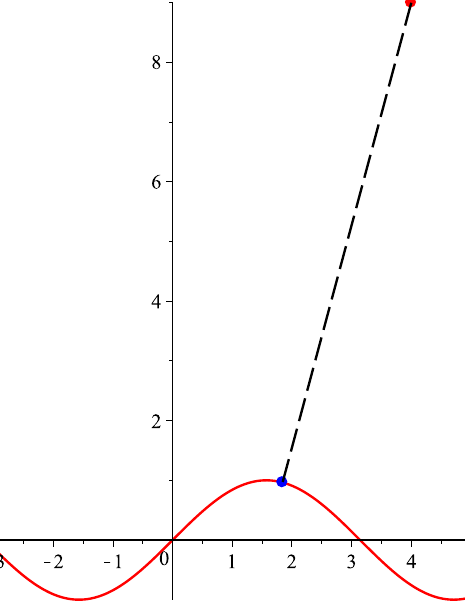
Figure 3. Geometric illustration of counterexample 3.